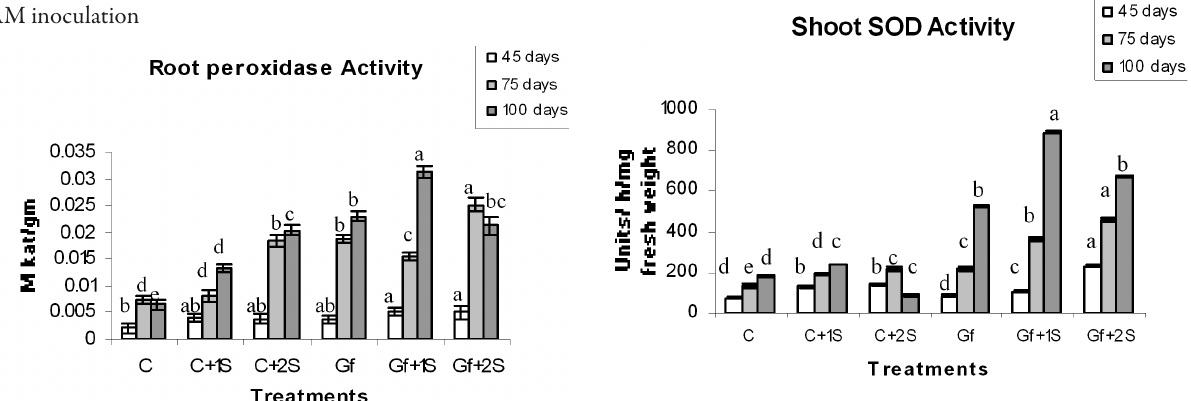
Fig. 10. Shoot superoxide dismutase activity in Gmelina arborea Roxb inoculated with Glomus fasciculatum after 45, 75 and 100 days after AM inoculation